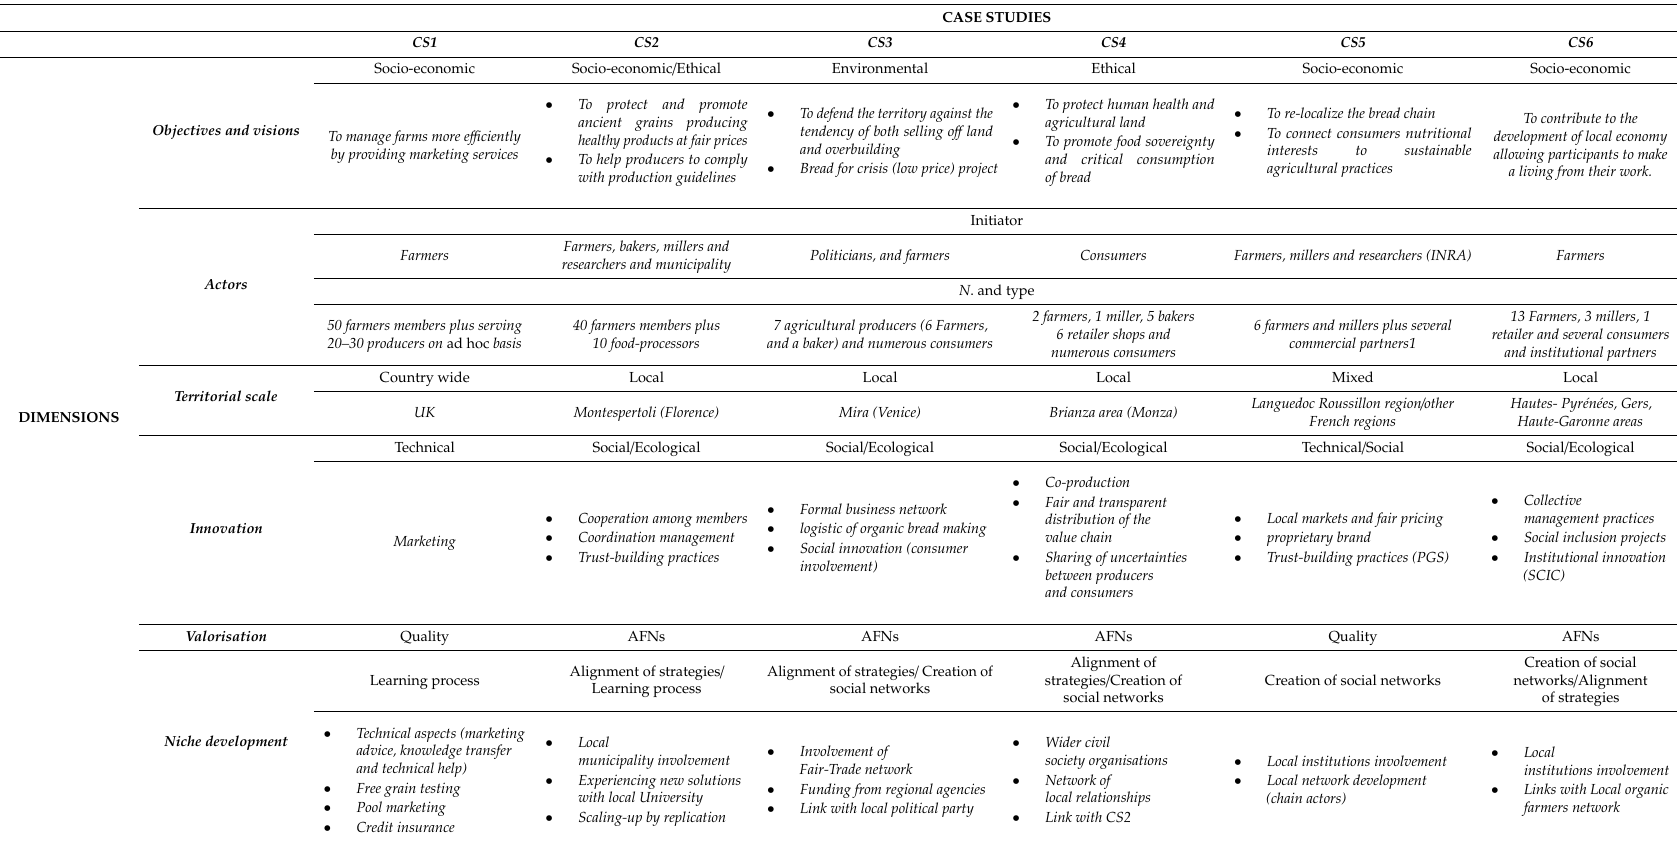
Table 1. Pilot application on agrobiodiversity transition in the wheat